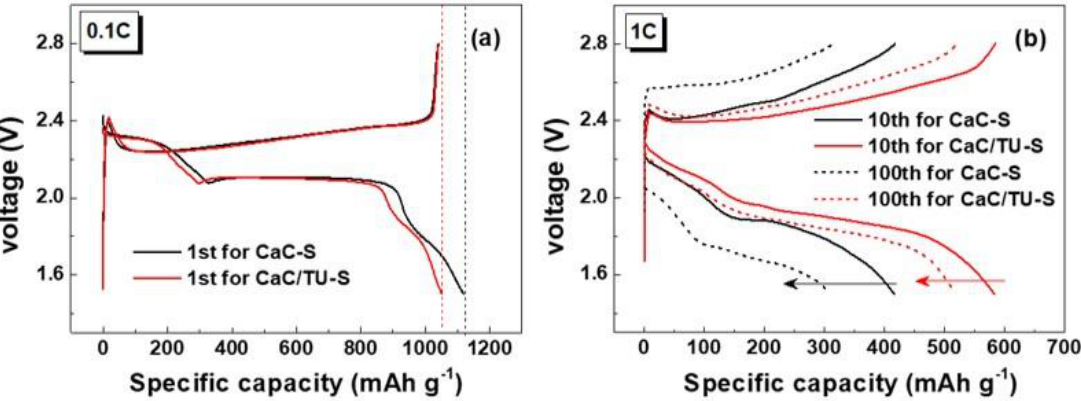
Figure 6. Charge/discharge profiles of the CaC-S and CaC/TU-S cells: ( a ) 1st cycle at 0.1 C rate; ( b ) 10th and 100th cycles at 1 C